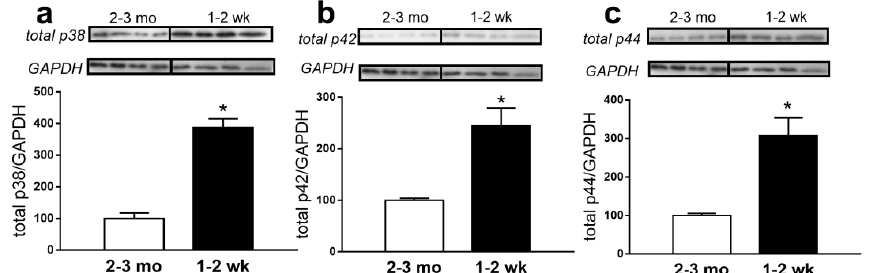
Figure 1. p38, p42 and p44 MAPK protein abundance is higher in saphenous arteries of 1- to 2-week- old rats. Protein abundance of MAPK p38 ( a ), n = 4, p42 ( b ), n = 4 and p44 ( c ), n = 4 in saphenous arteries of 2- to 3-month-old and 1- to 2-week-old rats. * p < 0.05 (unpaired Student t -test). Further, we evaluated whether p38 and p42/44 MAPKs are activated during α 1 -adrenoceptor stimulation in saphenous arteries of 2- to 3-month-old and 1- to 2-week-old rats by measuring their phosphorylation level upon activation by a submaximal concen- tration of the α 1 -adrenoceptor agonist methoxamine (MX, up to 10 µ M, see Methods). In addition, the effects of MAPK inhibitors on arterial contractile responses to MX were also